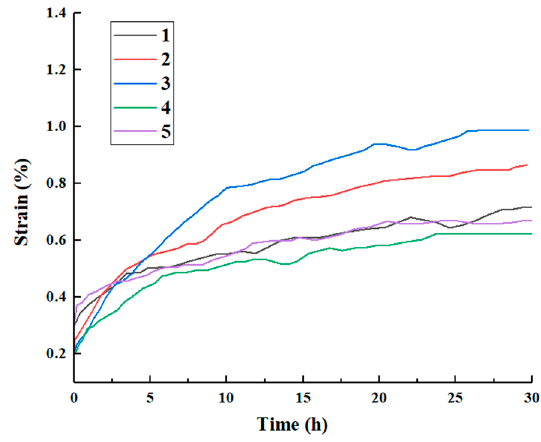
Figure 3. Creep curve diagram.